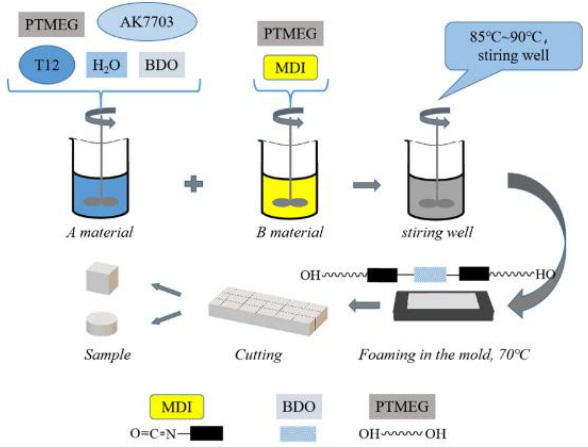
Figure 1. Technological process of preparing PUMEs.